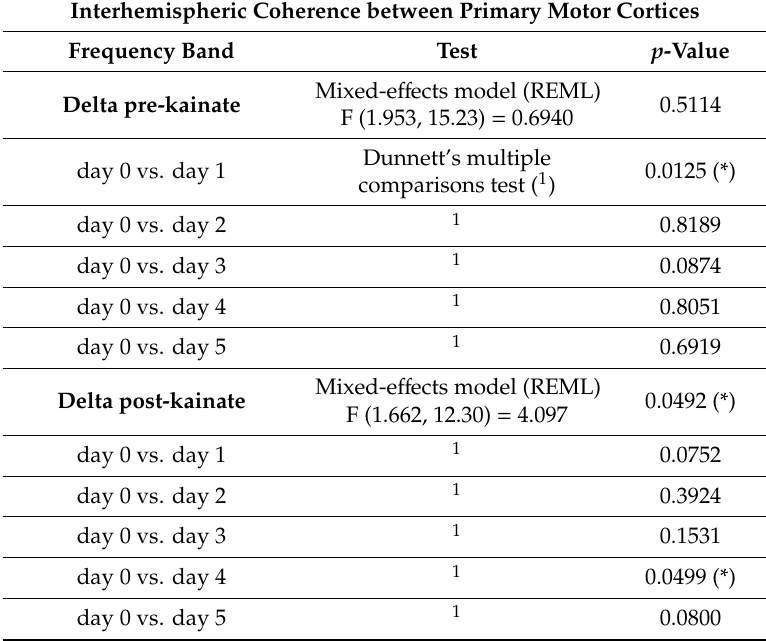
Figure 3. ( a ) Imaginary interhemispheric coherence during baseline and kainate day per frequency band. Results are expressed as average ± the standard error of the mean. ( b ) Imaginary interhemispheric coherences across 0.5–100 Hz frequencies (average) (** for p < 0.01).